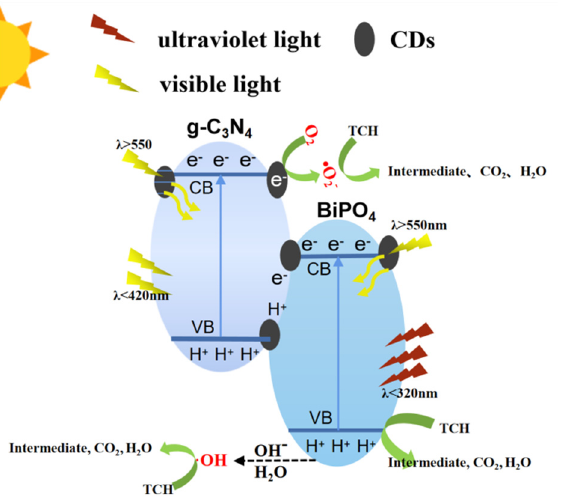
Figure 10. Schematic image of the probable photocatalytic mechanism for TC degradation over the